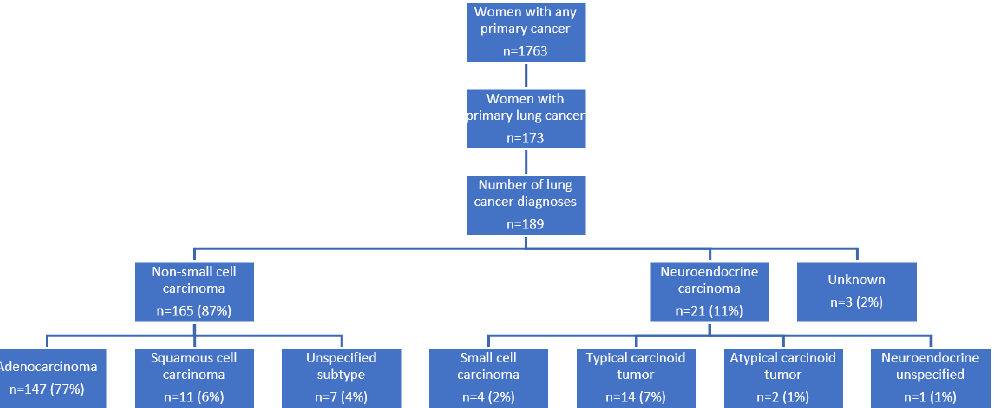
Figure 1. Frequency of women lung cancers and histological distribution at the WTC EHC as of 1 July 2021.